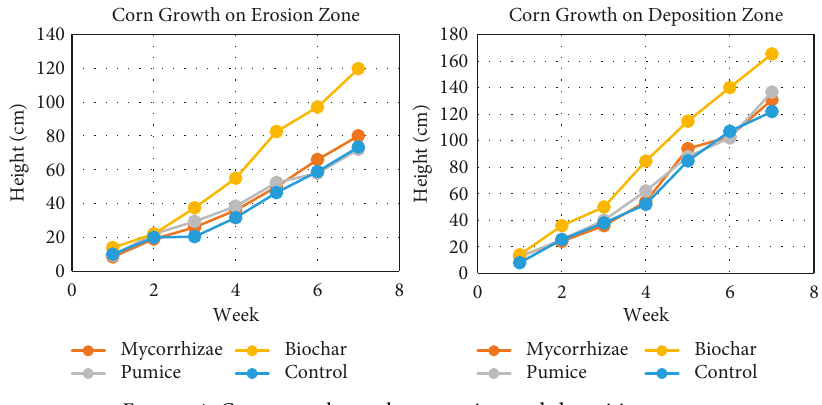
Figure 4: Corn growth graph on erosion and deposition zone. Table 3: Test results of element components of biochar and pumice.